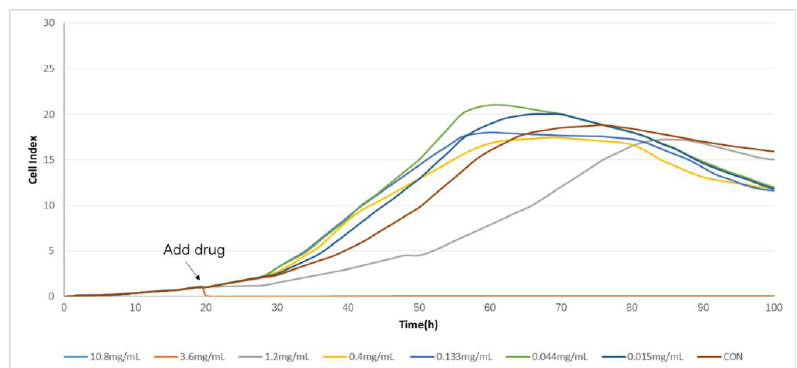
Figure 6. The time/dose-dependent cell response profiles (TCRPs) of the different concentration samples of CDDPs acting on MDA-MB-231 cells plotted against time with the mean of three experiments. The concentrations are: 10.8 mg/mL (light blue line), 3.60 mg/mL (medium brown line), 1.20mg/mL (gray line), 0.400 mg/mL (yellow line), 0.133 mg/mL (medium blue line), 0.044 mg/mL (green line), 0.015 (dark blue line), and control (dark brown line).